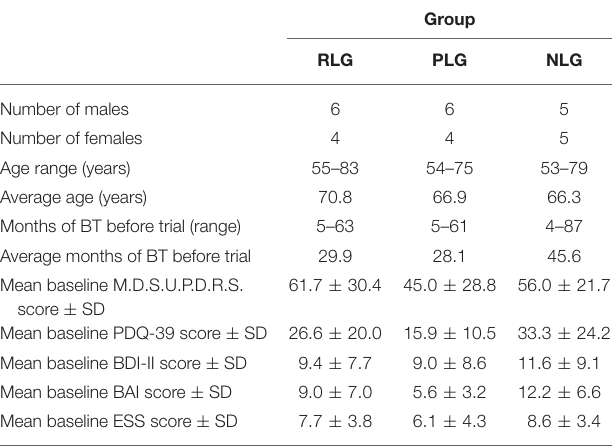
TABLE 1 | Patient Demographics describing the populations for each group employed in the